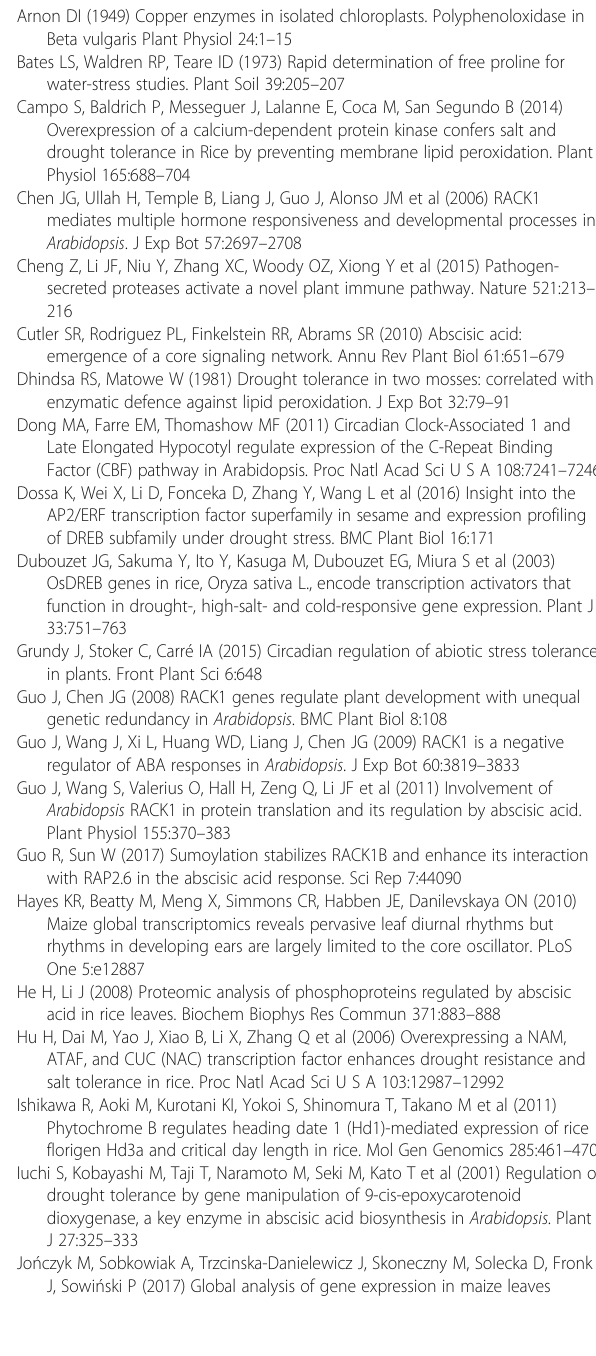
Additional file 1: Table S2. Primers used for the qRT-PCR analysis of various genes. Figure S1. Public microarray data showing OsRACK1A (A) and OsRACK1B (B) expression is controlled by a circadian clock (http:// www.ebi.ac.uk/arrayexpress/experiments/E-MTAB-275/). OsRACK1A